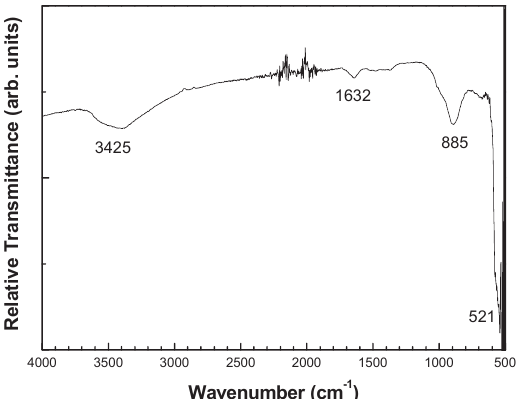
Fig. 6 Room-temperature FT-IR spectrum of the nano- sized ZnO powdered